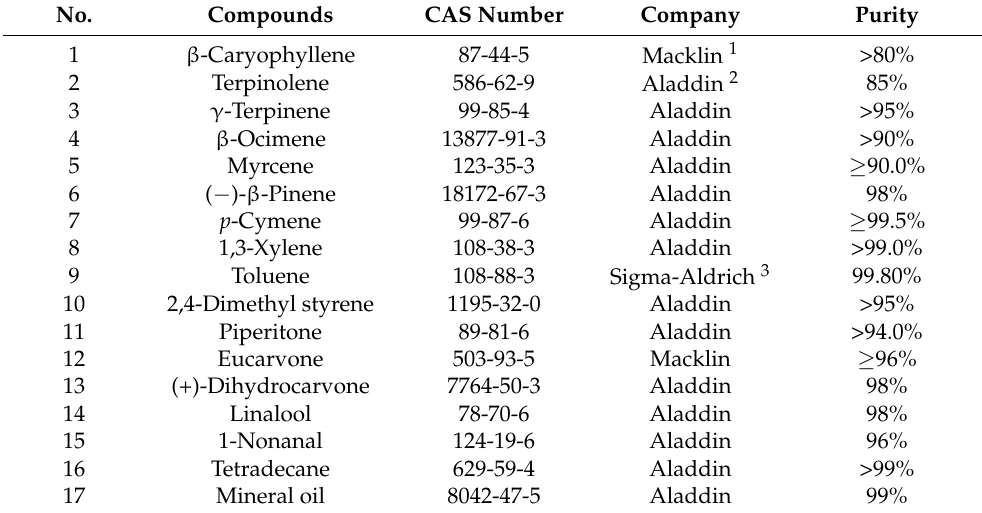
Table 1. Volatile compounds used as olfactory stimuli in the EAG and the Y-tube experiments tested with pollinators A. mellifera and B. terrestris